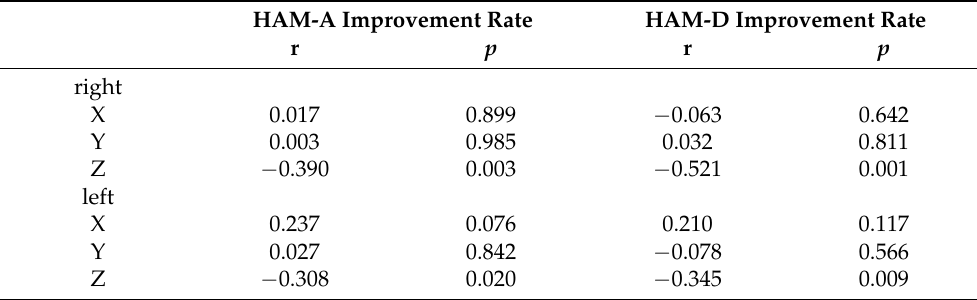
Table 2. HAM-A, HAM-D scores improvement rate and active contact locations.